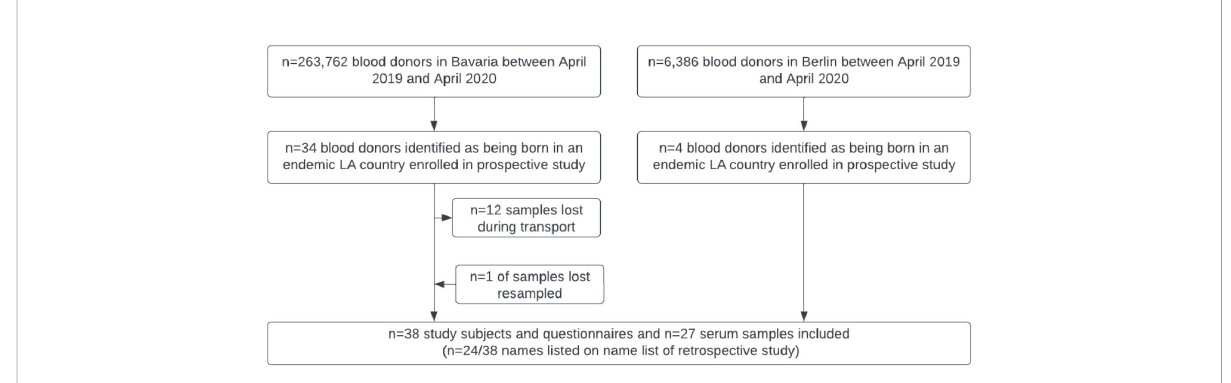
FIGURE 2 Selection algorithm of study subjects in the prospective